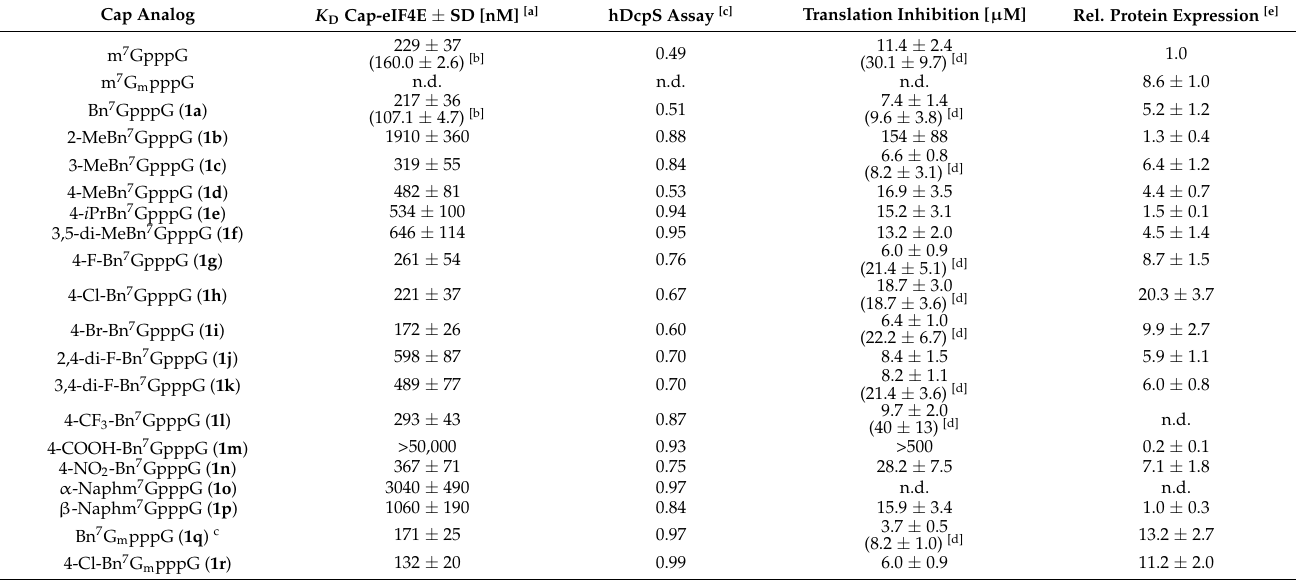
Table 2. Summary of the biochemical properties of N7-benzyl-containing cap analogs and RNAs co-transcriptionally capped with these